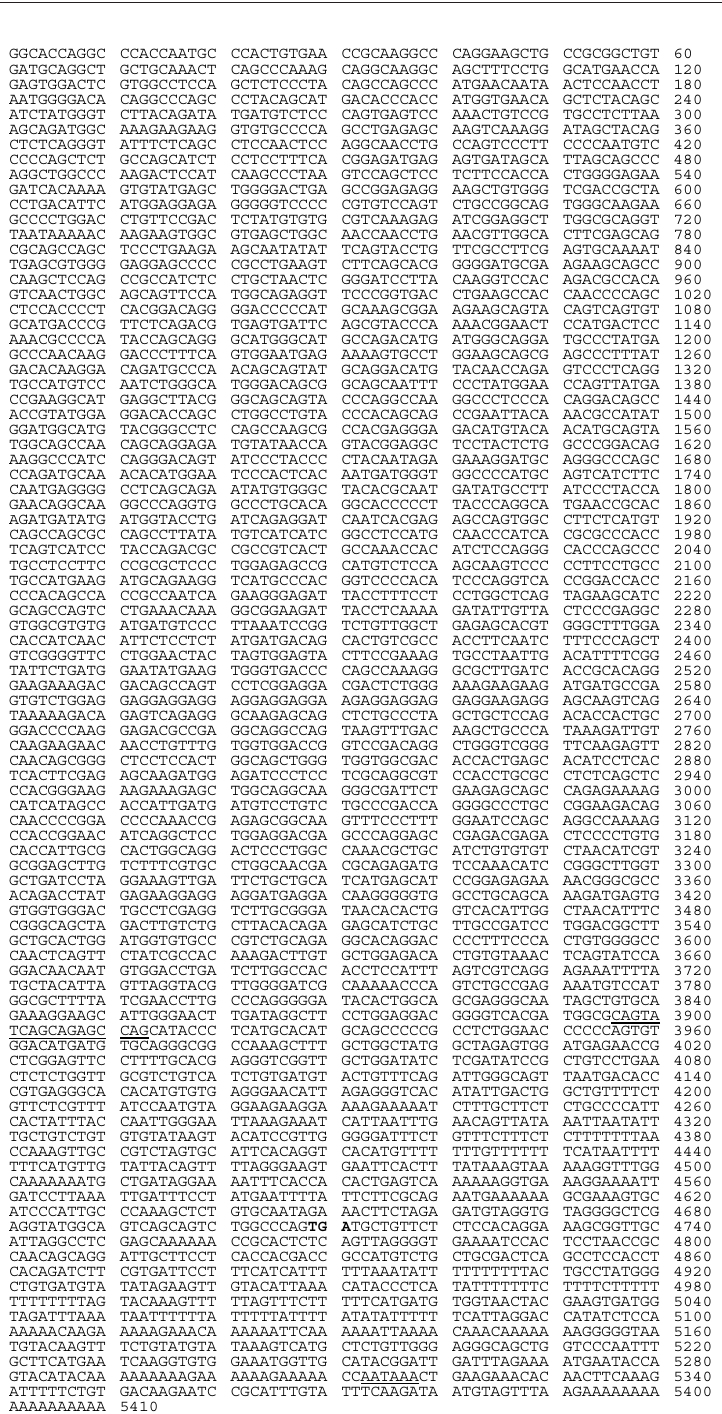
the synthetic phenotype. Indeed, results show that 6A3- 5 mRNA levels are increased by 300% (3-fold increase, n = 3) in synthetic SMCs (Figures 8a and 8b). One should